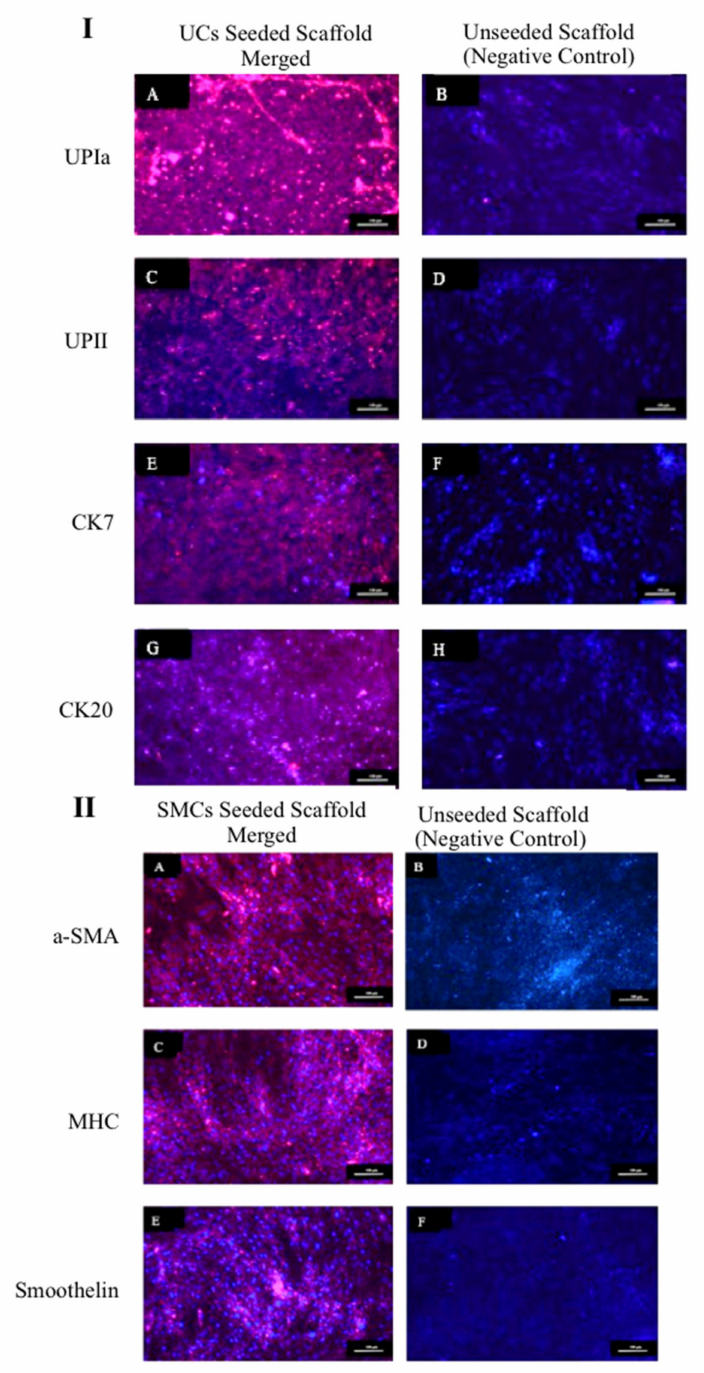
Figure 9. Immunocytochemical staining of seeded UCs ( I ) and SMCs ( II ) on ASC-based self- assembled scaffold. The expression of UPIa, UPII, CK7, and CK20 by UCs (IA,IC,IE,IG) and a-SMA, MHC and smoothelin by SMCs (IIA,IIC,IIE), are detected in red color. No UC and SMC marker expression was detected in negative control. 4’,6-diamidino-2-phenylindole (DAPI) was used as nuclear counterstain in blue color. The blue color detected in negative control (I and II), represents nuclei of UC (IB,ID,IF,IH) and ASCs (IIB,IID,IIF). The scale bar represents 100 µ m. Results are from a representative of three independent